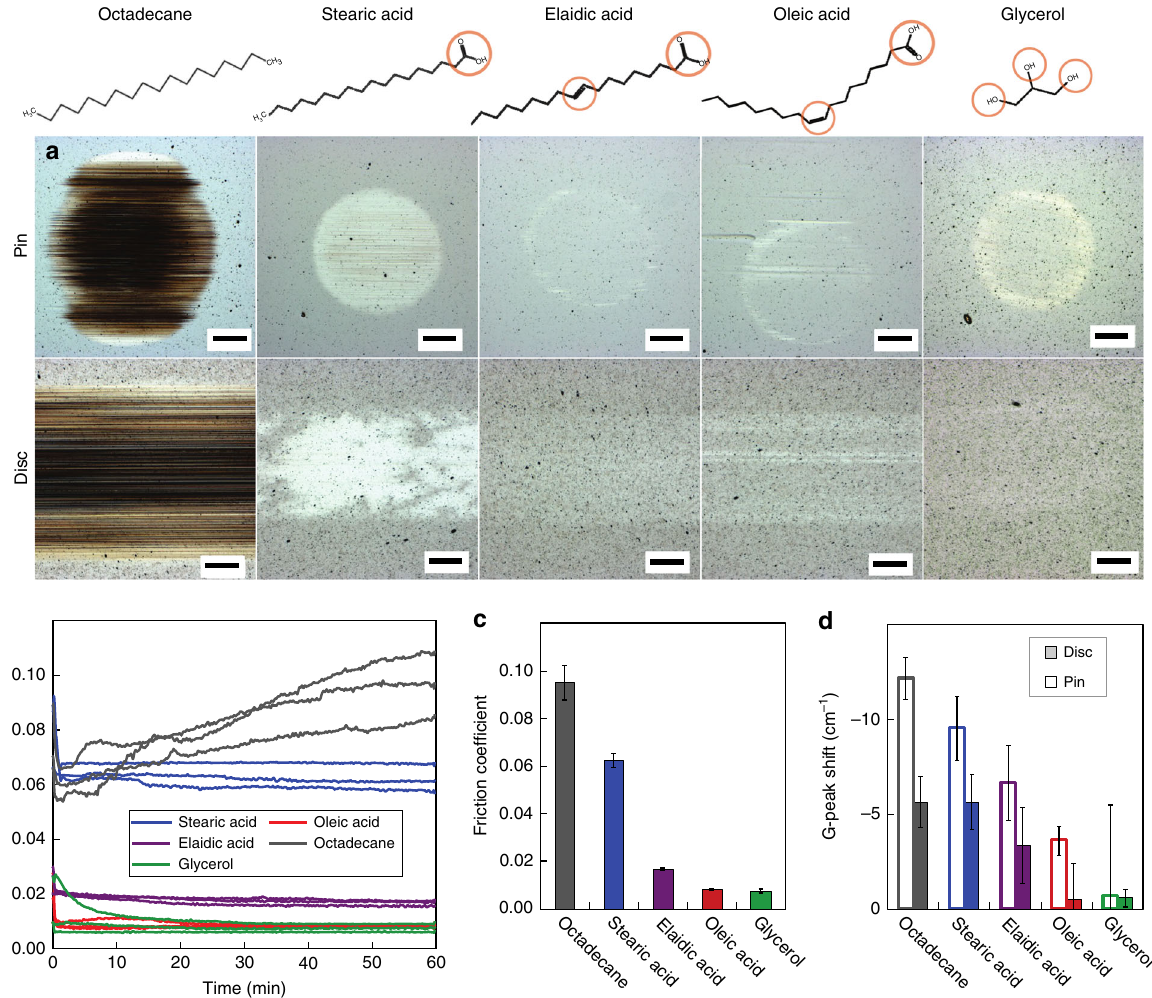
Fig. 1 Pin-on-disc test: sliding of a ta-C pin on a ta-C disc with octadecane (black), stearic acid (blue), elaidic acid (purple), oleic acid (red), and glycerol (green) lubrication. a Micrographs of the wear tracks on pin and disc at the end of a 1-h sliding test (scale bar: 200 μ m). b Evolution of the friction coef fi cient for the different lubricants. To ensure the reproducibility, three different tests were performed for each lubricant. c Mean friction coef fi cient 〈 μ 〉 of the last 10 min of the tests. d Raman G-peak shift of the ta-C on the pin and disc after sliding compared to